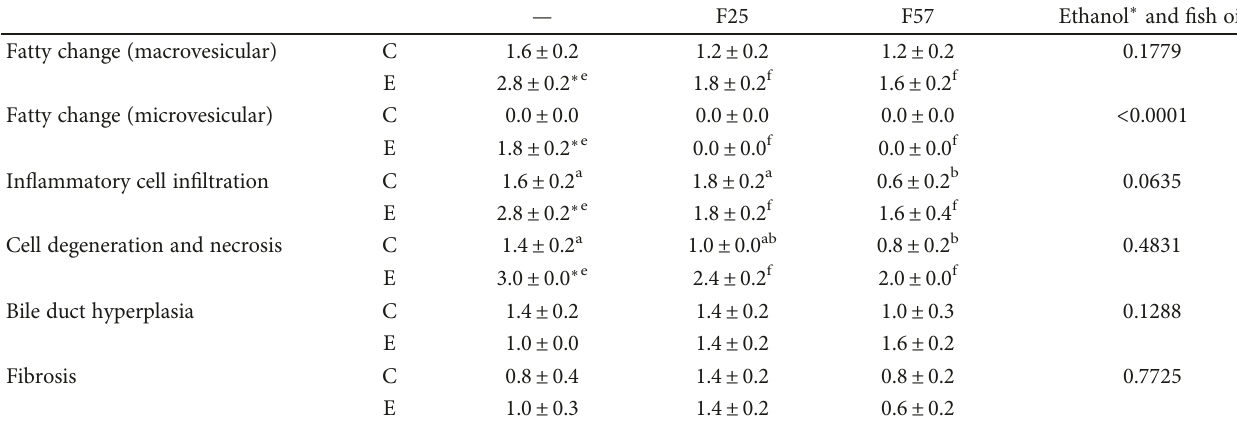
Table 3: Hepatic histopathology scores in each group 1,2 .